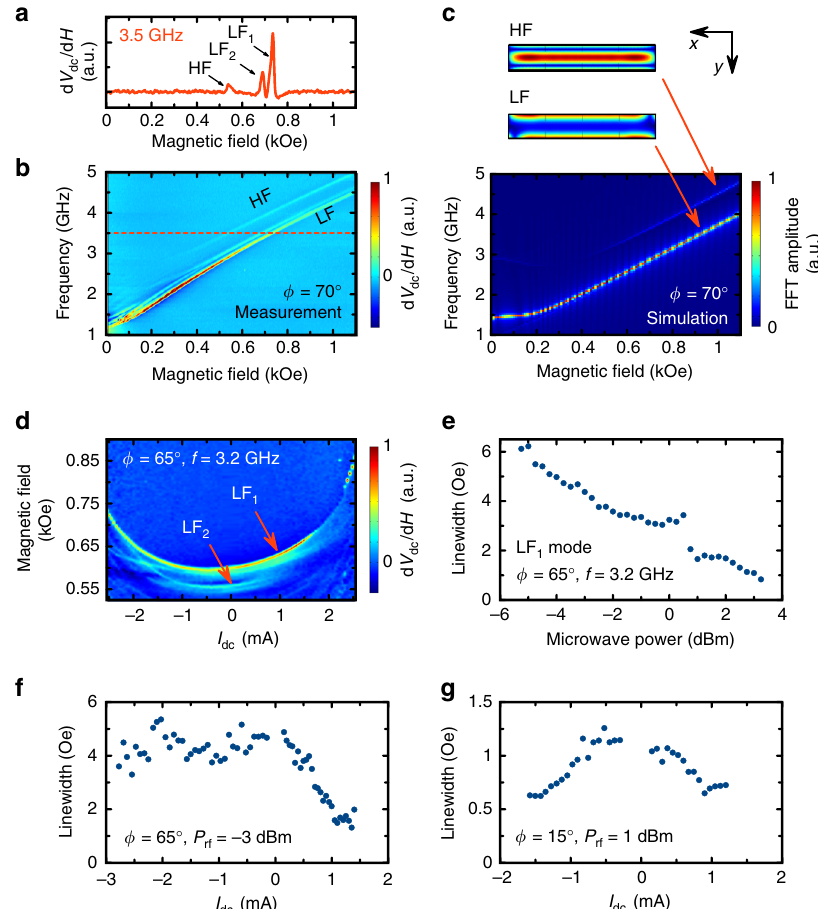
Fig. 4 ST-FMR measurements. a A single spin torque ferromagnetic resonance spectrum measured at a microwave frequency f = 3.5 GHz and magnetic fi eld angle ϕ = 70°. Low-frequency (LF) and high-frequency (HF) modes are observed. b ST-FMR spectra of the YIG/Pt nanowire measured as a function of magnetic fi eld and drive frequency at the fi eld angle ϕ = 70°. c Micromagnetic simulation of the spin wave eigenmode spectra in the YIG/Pt nanowire with a top view of the spatial dependence of the LF and HF mode amplitudes. d ST-FMR spectra measured as a function of magnetic fi eld and direct current bias current I dc for microwave power P rf = − 3 dBm. e Linewidth of the LF 1 measured as a function of the microwave drive power P rf . f Linewidth of the LF 1 mode as a function of direct current I dc for ϕ = 65° and P rf = − 3 dBm. g Linewidth of the LF 1 mode as a function of direct current for ϕ = 15° and P rf = 1